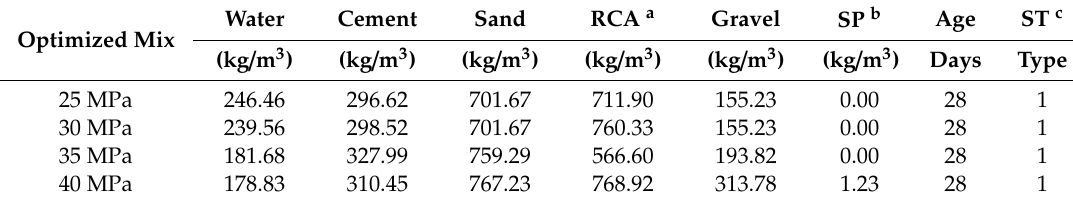
Table 9. Optimized mixtures.